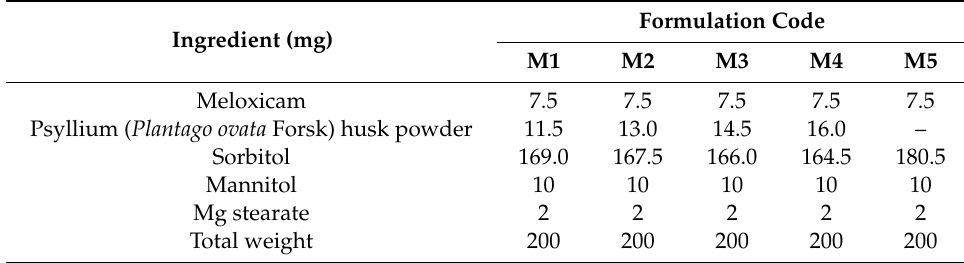
Table 1. The composition of orally disintegrating meloxicam tablets.